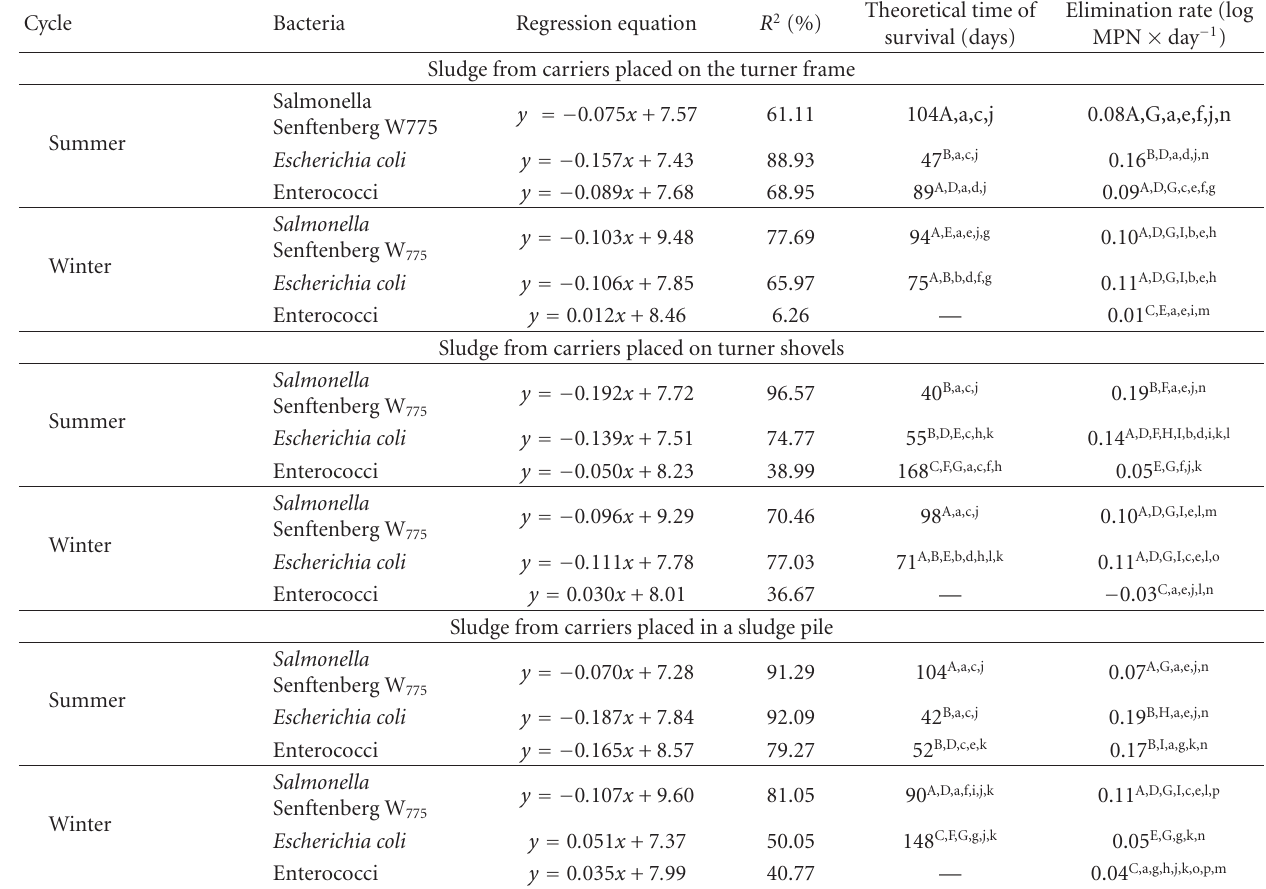
Table 5: Results of statistical analysis of obtained microbiological